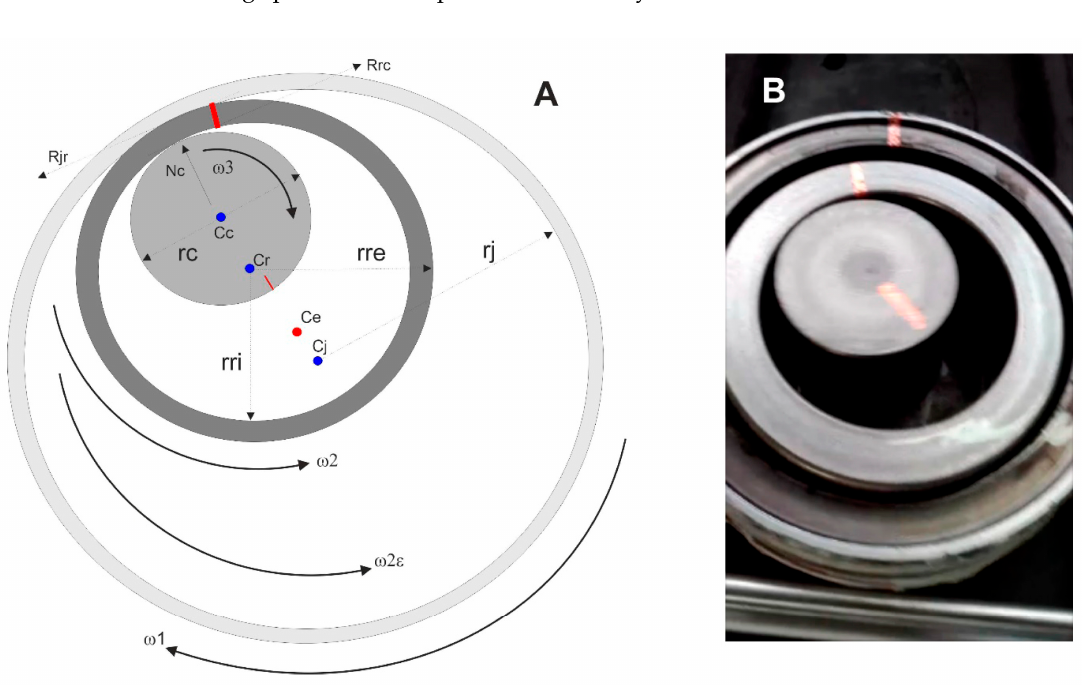
Figure A1. Diagrams of the movements of the grinding masses in a ring mill. Simplified model of the gearing; Nc = Normal Force between cylinder and ring, Rjr = Resistance force between jar and ring, Rrc = Resistance force between ring and cylinder, rc = cylinder radius, rri = ring internal radius, rre = ring external radius, rj = jar radius, Cc = cylinder geometrical center, Cr = ring geom. Center, Ce = eccentric center, CJ = jar geom. Center, ω 1, ω 2, ω 2 ε , ω 3 = rotation frequencies of jar, ring, ring eccentric and